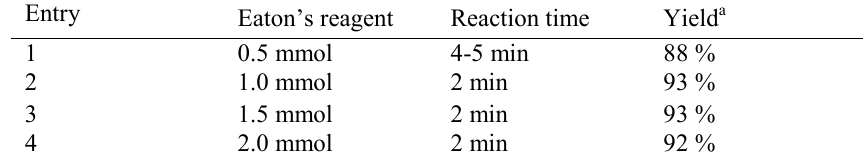
Table 2. Effect of molar ratio on the condensation of Indole(2 mmol) with benzaldehyde(1 mmol) to produce ( 3a